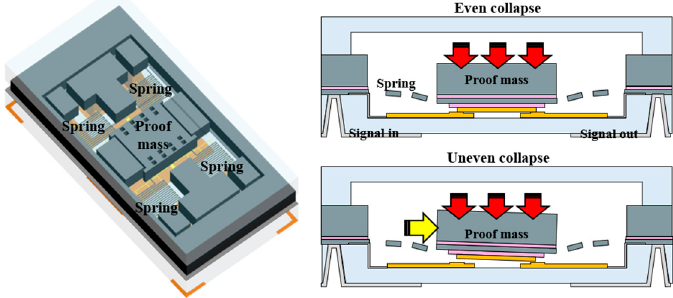
Figure 1. Perspective and cross-section schematics of the low-g MEMS acceleration switch developed by Kim’s group